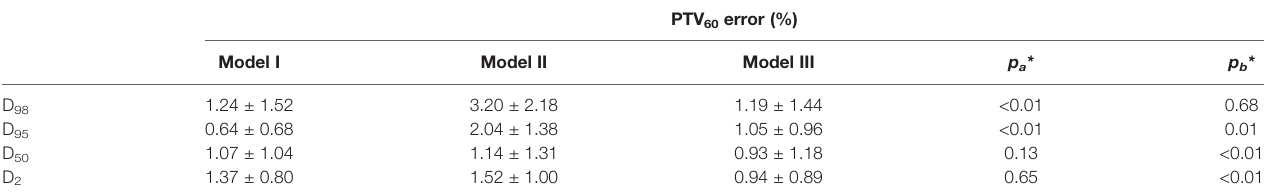
TABLE 2 | Means and standard deviations (Mean ± SD) of absolute differences for clinical DVH metrics between the predicted and ground truth